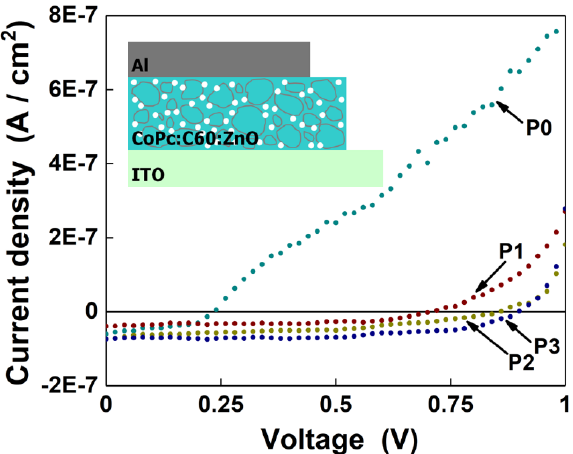
Figure 8. Current-voltage (J-V) characteristics of the structures based on the MAPLE-deposited layers. Inset: schematic representation of the structure developed with the MAPLE hybrid nanocomposite thin film.